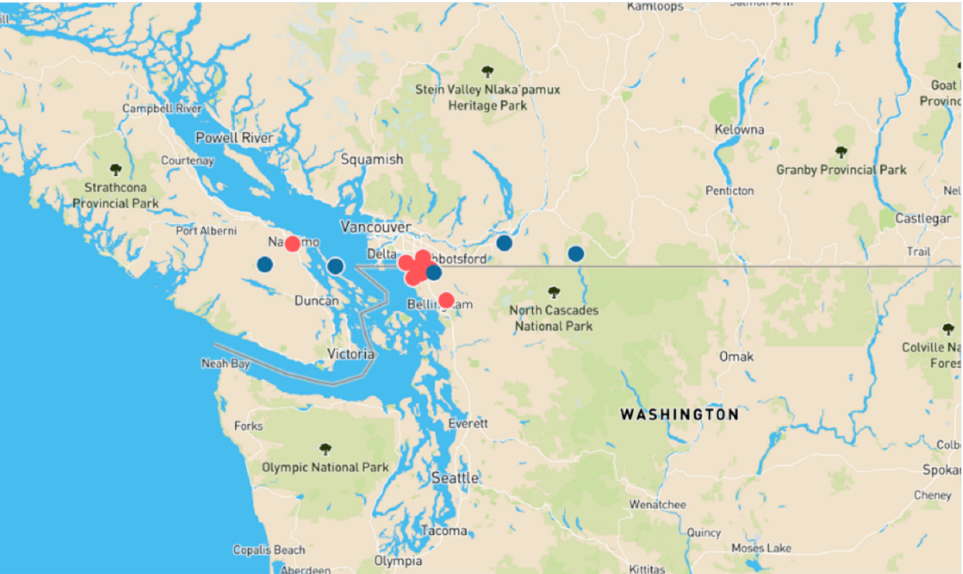
Figure 4. The results of fitting Asian giant hornets’ spread range. Note: The red circle represents the distribution of Asian giant hornets in the data, and the blue circle represents the distribution of Asian giant hornets predicted by fitting.